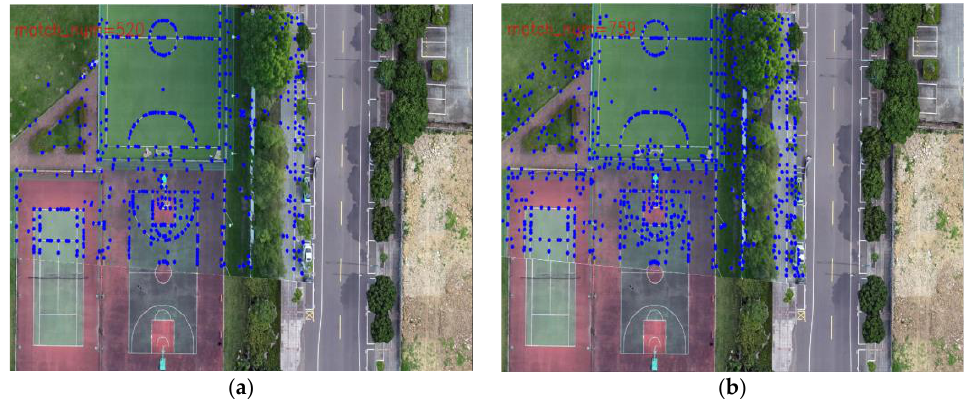
Figure 14. Registration effect: ( a ) match with map; ( b ) match with the transformed previous frame.